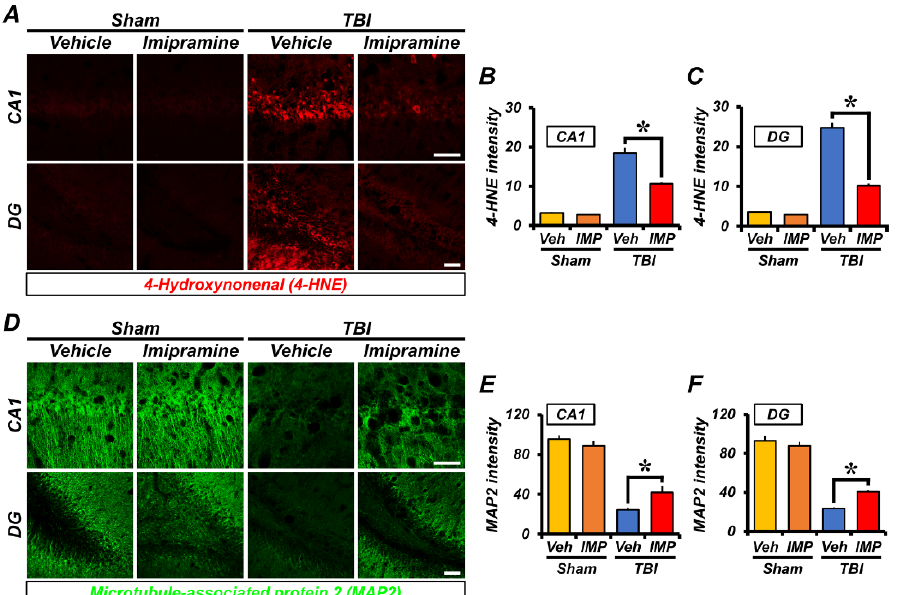
Figure 3. Imipramine treatment decreased lipid peroxidation and microtubule damage 24 h after TBI. ( A ) Immunofluorescence images showing lipid peroxidation marker 4-HN-stained (red) hippocampal CA1 and DG. Scale bar = 100 µ m. ( B , C ) Quantification of 4-HNE fluorescence-positive intensity in hippocampal CA1 and DG. Data are mean ± SEM; n = 4 from each sham group; n = 6 from each TBI group. * p < 0.05 vs. vehicle-treated TBI group. ( D ) Representative fluorescence images showing microtubule marker MAP-2-stained (green) hippocampal CA1 and DG with nuclei (blue). Scale bar = 100 µ m. ( E , F ) Quantification of MAP-2 intensity in hippocampal CA1 and DG. Data are mean ± SEM; n = 4 from each sham group; n = 6 from each TBI group. * p < 0.05 vs. vehicle-treated TBI group.